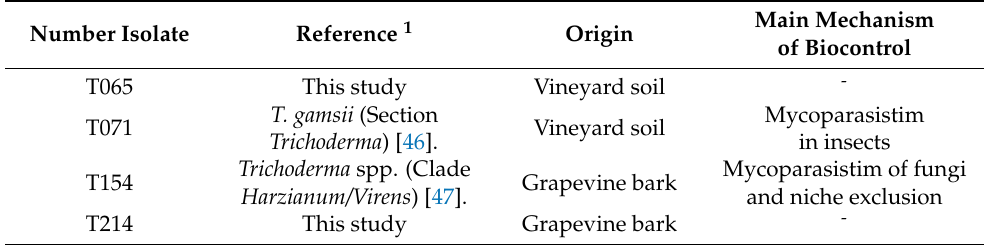
Table 1. Trichoderma isolates used in this